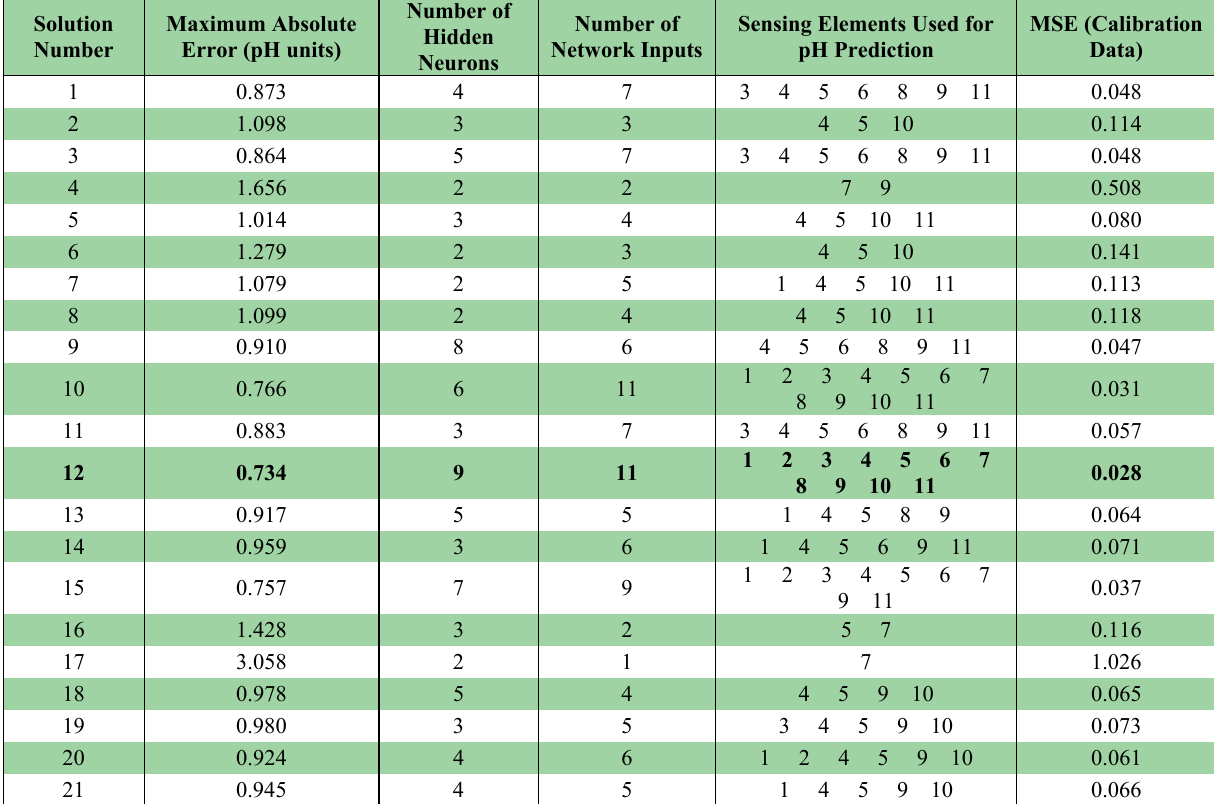
Table 1. Performance of resulting networks from hybrid NSGA-II in